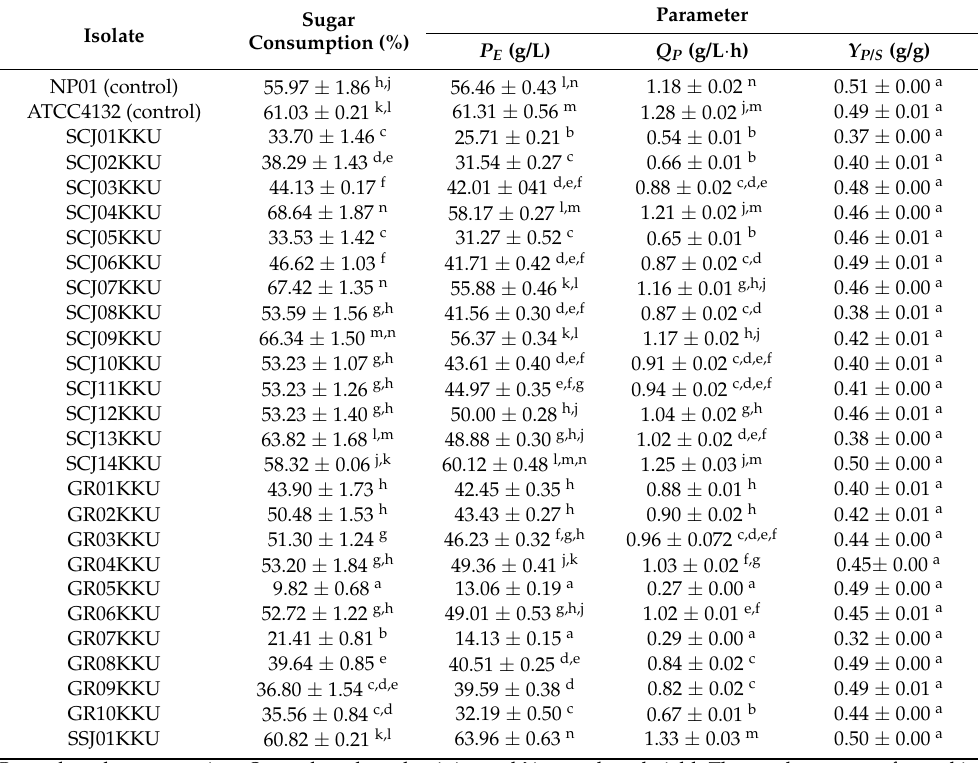
Table 1. Fermentation parameters of batch ethanol production from the SSJ medium containing 200 g/L of total